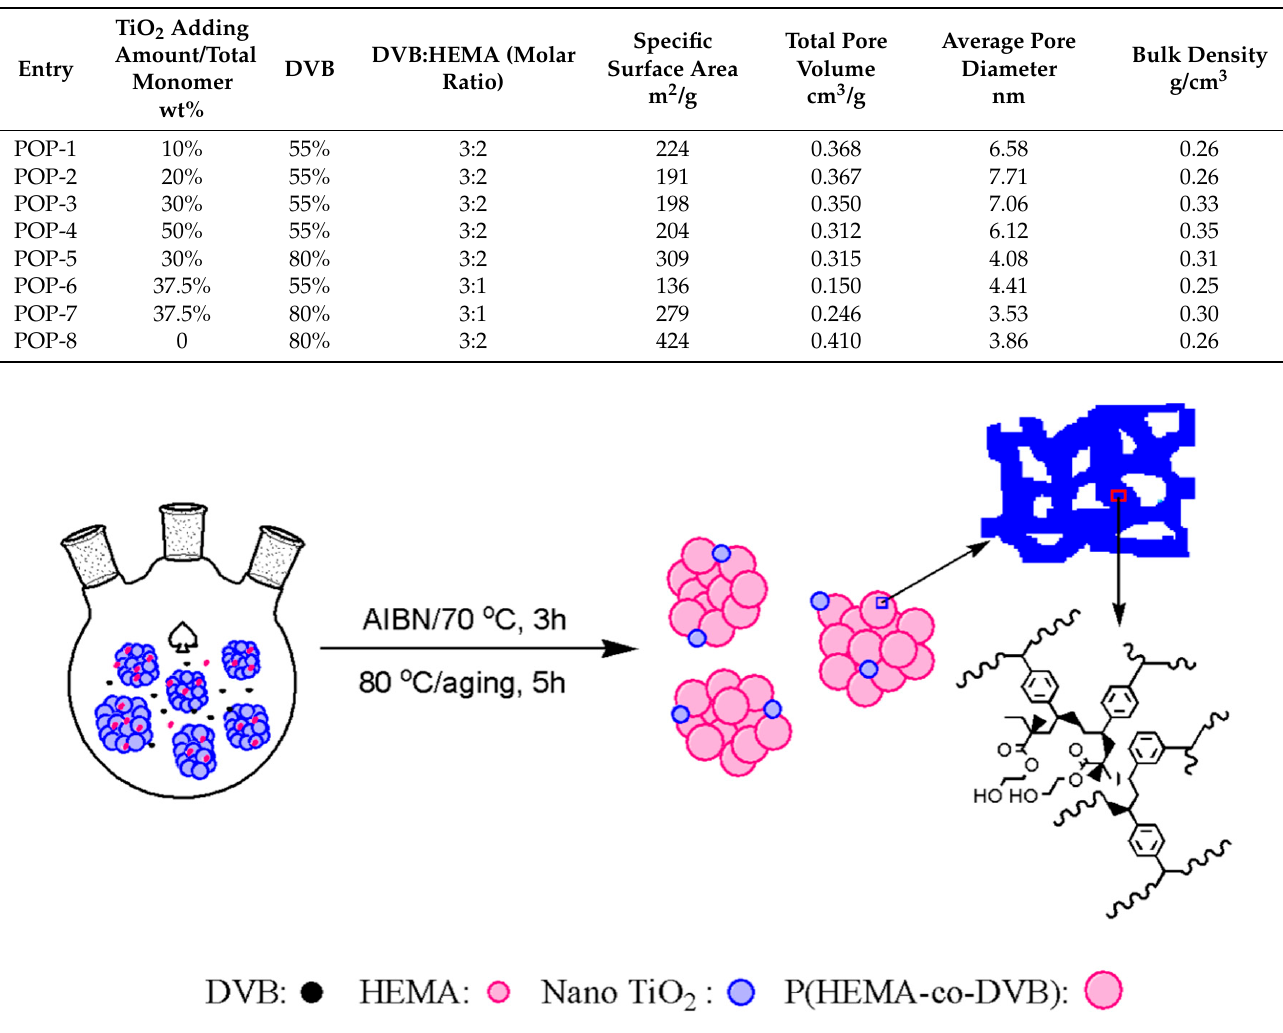
Figure 1. Preparation of TiO 2 /POP particles. Table 1. Pore structure from N 2 sorption and bulk density results of nano TiO 2 /POP particles.